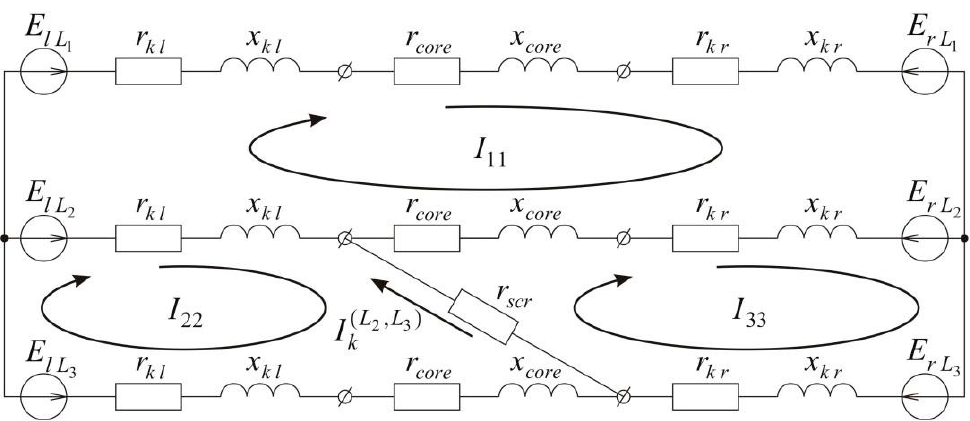
Figure 4. Equivalent circuit of the part of electrical network between two WTGs to calculate the double line-to-screen fault current with given directions of the mesh-currents.